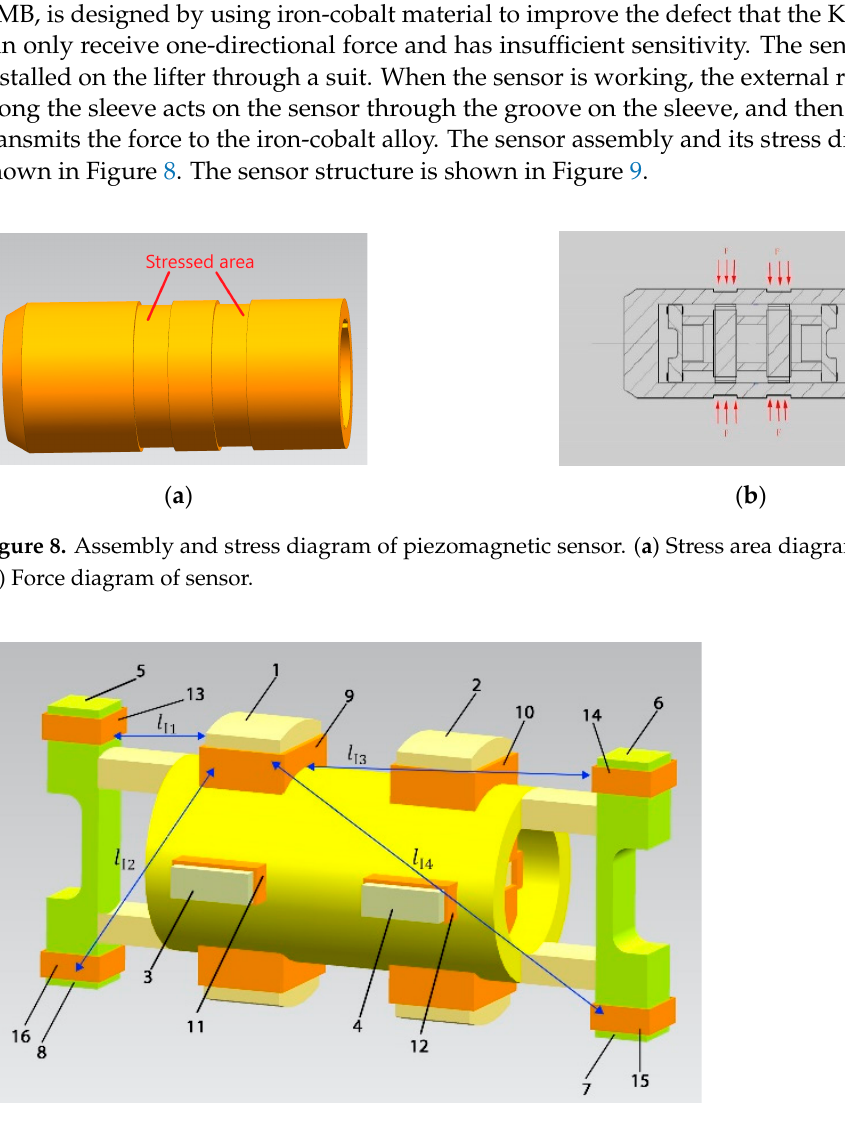
Figure 9. Structure diagram of piezomagnetic sensor. 1. Vertical excitation core I; 2. Vertical excita- tion core II; 3. Horizontal excitation core I; 4. Horizontal excitation core II; 5. Induction core 1; 6. Induction core 3; 7. Induction core 4; 8. Induction core 2; 9 , 10 , 11 , 12. Excitation coil ； 13 、 16 、 14 、 15 ． Induction coil1 、 2 、 3 、